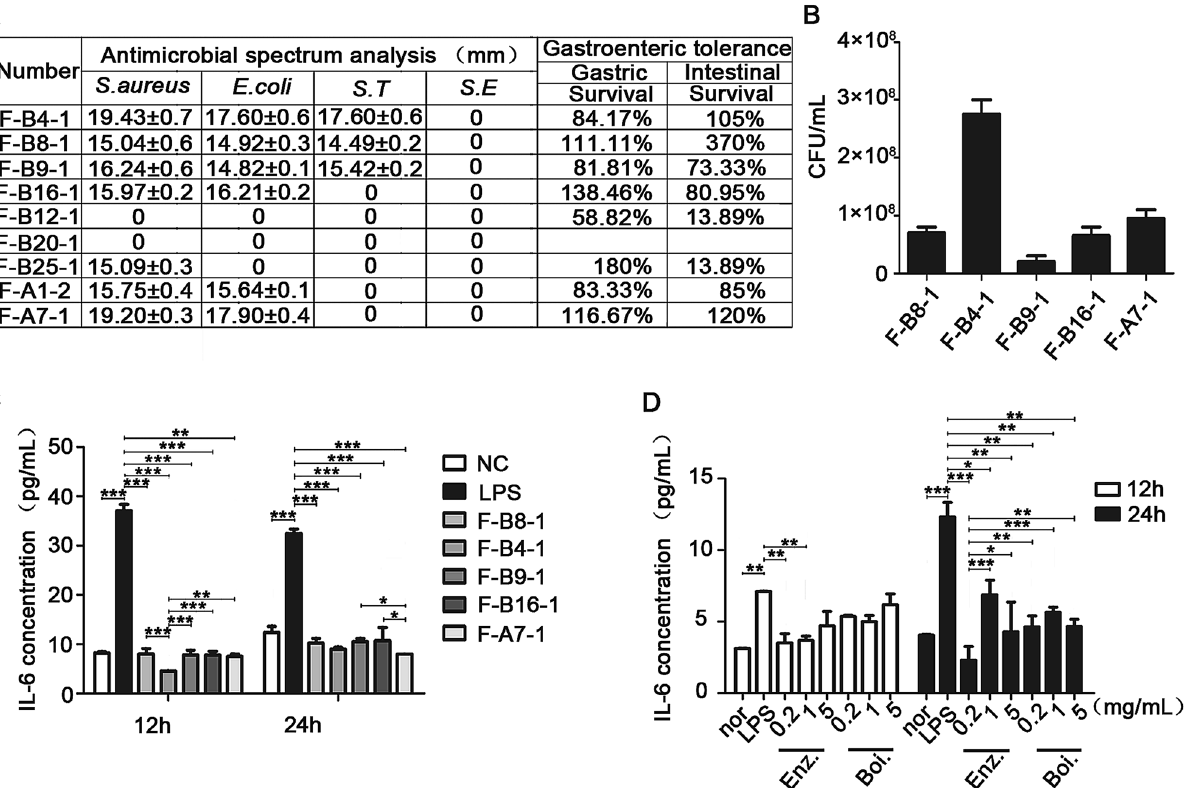
Figure 1. Screening of probiotics and comparison of two traditional extraction methods of Danshen. ( A ) Antibacterial spectrum analysis of probiotics and gastrointestinal fluid tolerance. F-B4-1 ( Lactobacillus Rhamnosus ), F-B8-1 ( Lactobacillus Plantarum ), F-B9-1 ( Lactobacillus Fermenti ), F-B16-1 ( Lactobacillus Casei ), F-B12-1 ( Streptococcus Thermophilus ), F-B20-1 ( Leuconostoc Mesenteroides ), F-B25-1 ( Lactobacillus Harbin ), F-A1-2 ( Bacillus Subtilis ), F-A7-1 ( Bacillus Subtillis Natto ). ( B ) The CFU was detected after cultured for 24 h. ( C ) IL-6 levels were examined in the supernatant of Caco-2 cells which were pretreated with 50 ug/mL LPS for 12 h, then treated with sterilized probiotic liquid for 12 h or 24 h. All groups (NC, F-B8-1, F-B4-1, F-B9-1, F-B16-1, F-A7-1) were statistically analyzed compared with the LPS group. Statistical analysis was conducted between F-B4-1 group and other groups (F-B8-1, F-B9-1, F-B16-1, F-A7-1) at 12 h. Statistical analysis was conducted between F-A7-1 group and other groups (F-B8-1, F-B4-1, F-B9-1, F-B16-1) at 24 h. ( D ) Enz. (enzymolysis), Boi. (boiled). IL-6 levels were examined in the supernatant of Caco-2 cells which were pretreated with 50 μg/mL LPS for 12 h, then treated with different concentrations of the two traditional extraction methods of Danshen for 12 h or 24 h. All groups (Nor, Enz., Boi.) were statistically analyzed with the LPS group. At 24 h, 0.2 mg/mL Enz. group was compared with other treatment groups. (Data are expressed as means ± S.E., * p < 0.05, ** p < 0.01 and *** p <